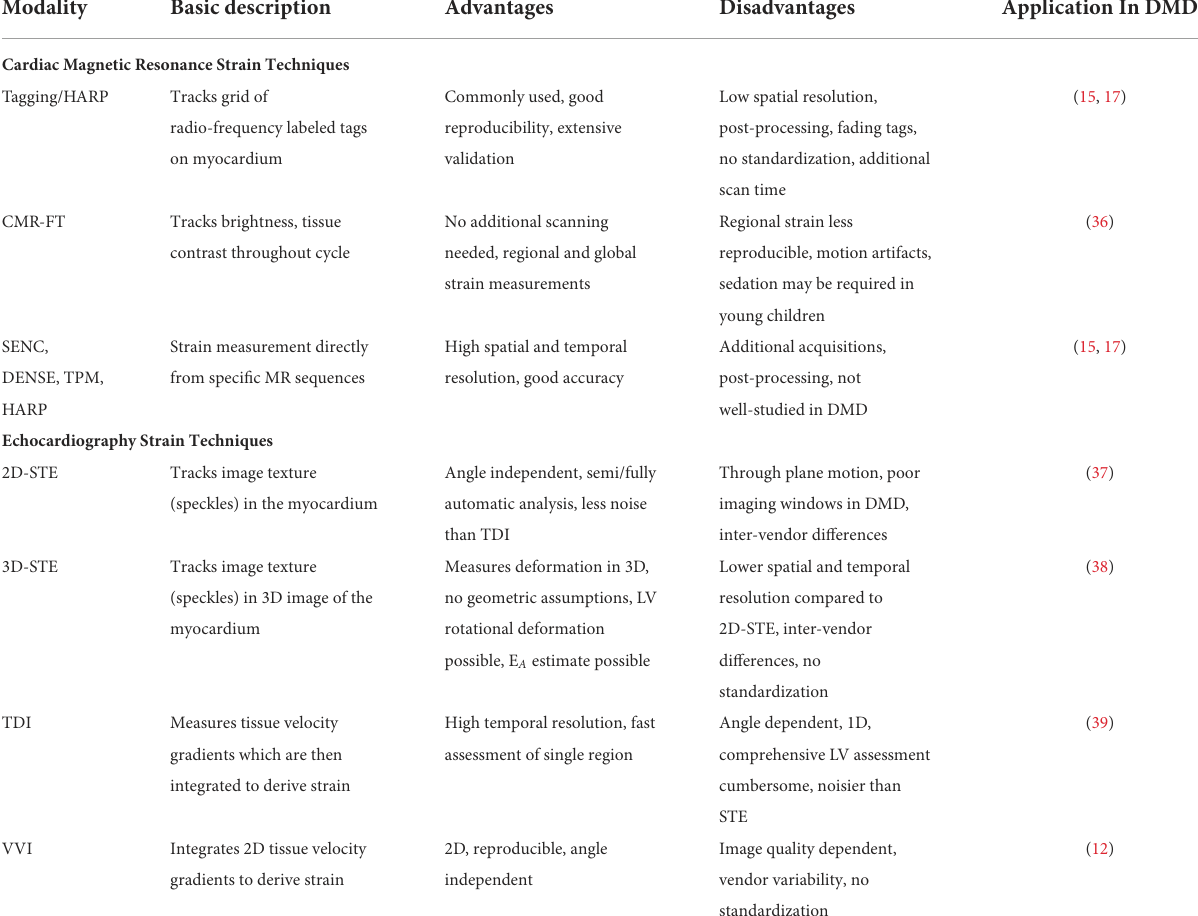
TABLE 1 Stain imaging technique comparison in